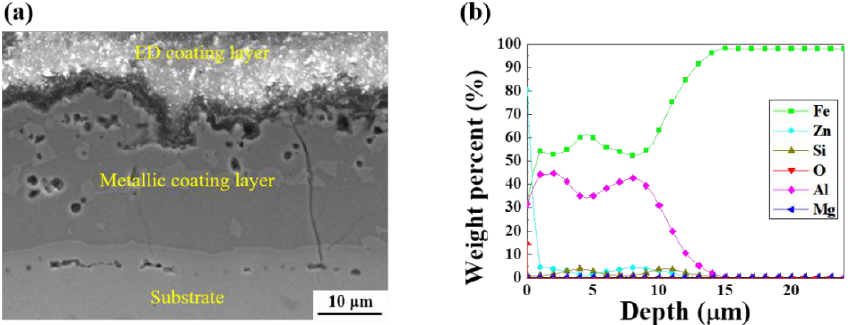
Figure 10. ( a ) Cross-sectional observation and ( b ) GDS depth profile of ED-treated AlSiZnMg-MC.